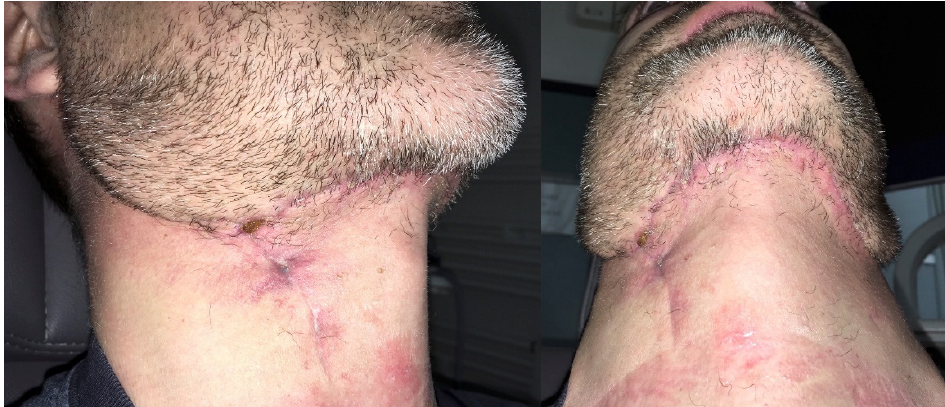
Figure 7. Submental and neck scar at 2 months after surgery.